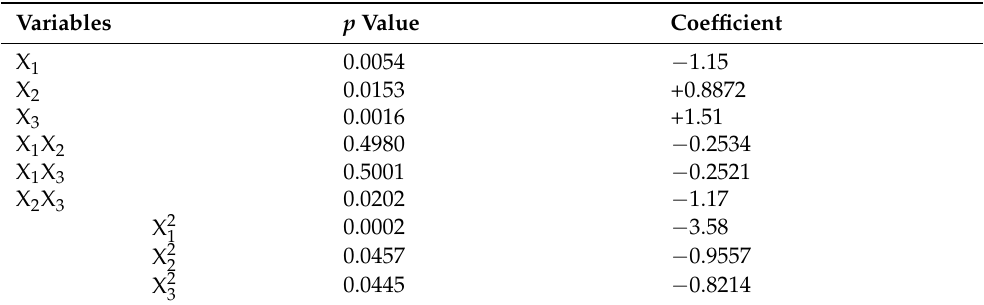
Table 2. Effects of the independent variables on the dependent variables and their statistical signifi- cance with respect to the extraction of flavonoid compounds from